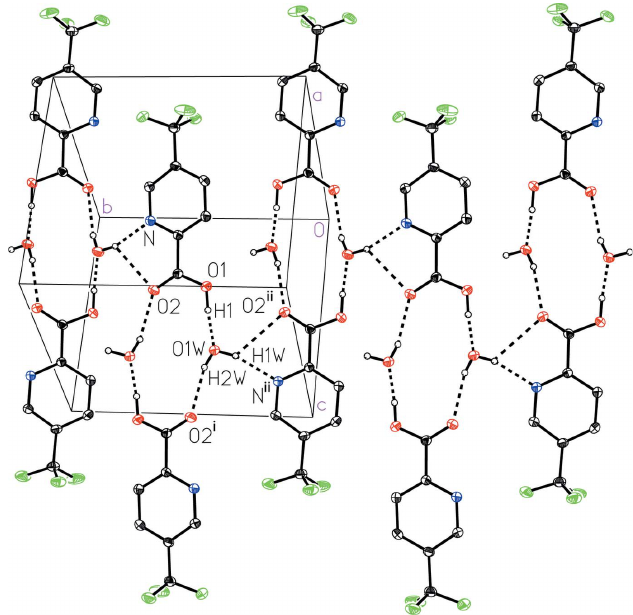
Figure 1 A view of 5-(trifluoromethyl)picolinic acid (I) hydrate with the atom- numbering scheme. Displacement ellipsoids are shown at the 50% probability